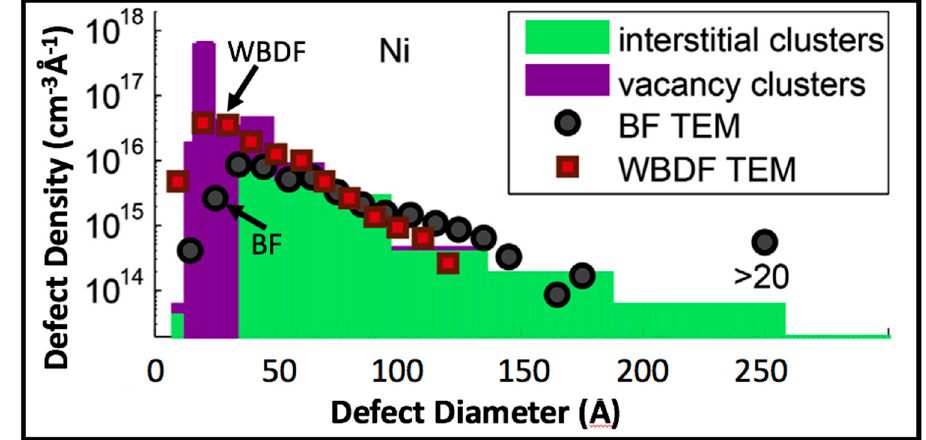
Figure 6. Semi-log plot of X-ray-determined vacancy and interstitial defect cluster size distributions (colored histograms), and TEM-determined combined vacancy and interstitial defect cluster size distributions using both bright-field and weak-beam dark-field TEM. Adapted from Figure 8 in Reference [34] with permission.